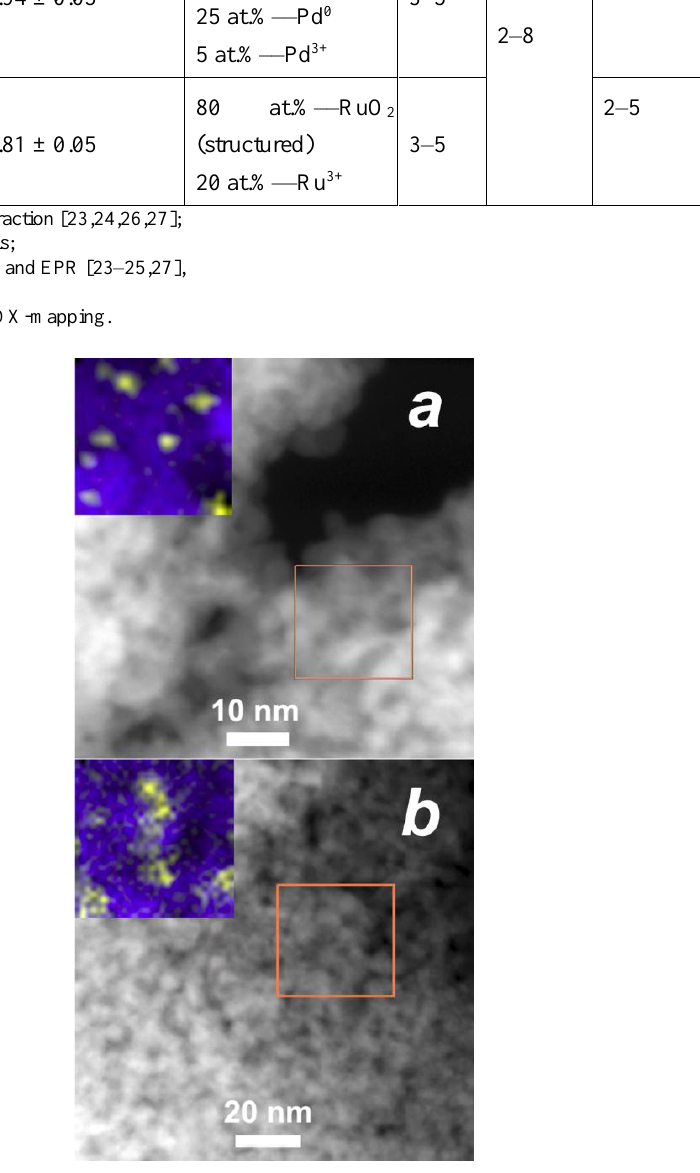
Figure 2. HAADF-STEM images of ( a ) SnO 2 /PdO x and ( b ) SnO 2 /RuO y samples; inset—EDX maps of selected areas (blue—Sn, yellow—noble